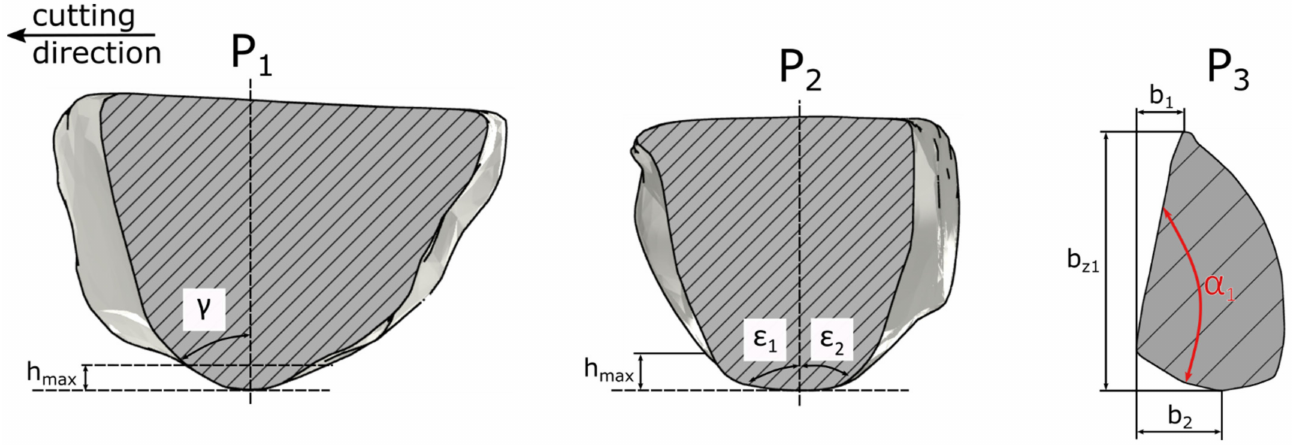
Figure 7. Geometrical properties of the abrasive grain ZS3.